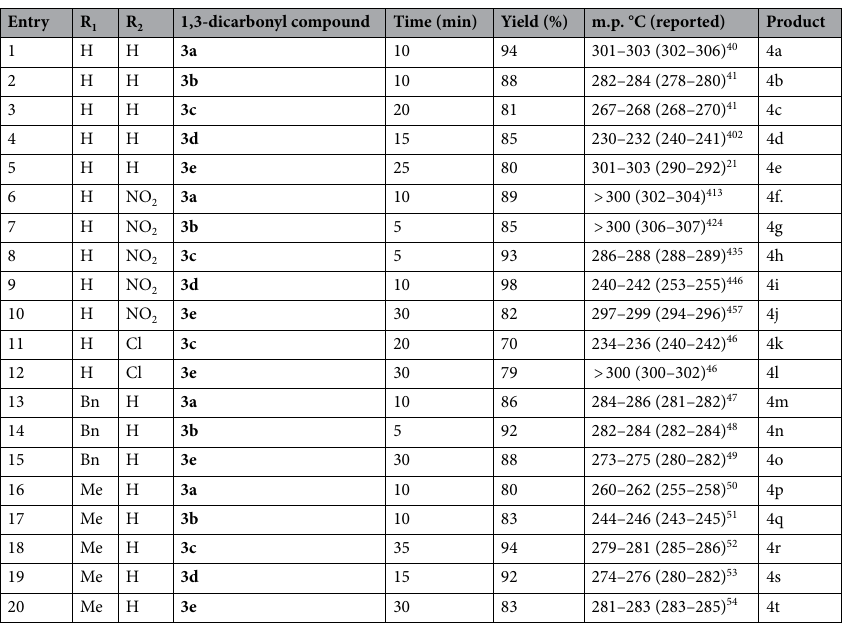
Table 1. Synthesis of spirooxindole derivatives in the presence of Fe 3 O 4 @SiO 2 /ECH/IG. *Reaction condition: Isatin 1 (1 mmol), 2 (1 mmol), 1,3-dicarbonyl 3 (1 mmol), 10 mg catalyst, and 3 ml solvent at 60